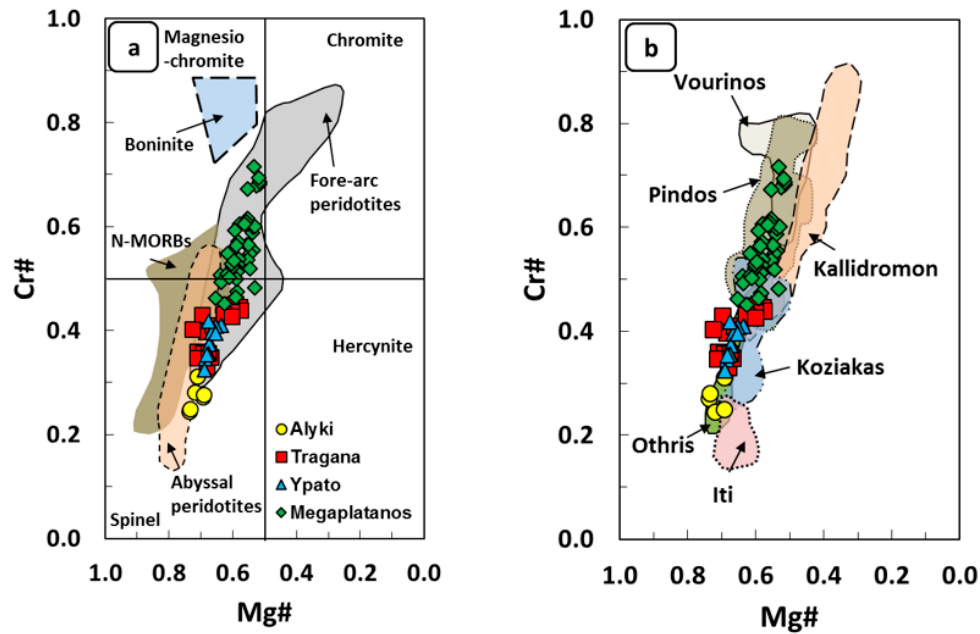
Figure 4. ( a ) Cr-spinel compositions from Lokris and Beotia peridotites, in terms of Cr# vs. Mg#. Data for spinel in modern abyssal peridotites are from [1,29]. Field for spinel in boninites is taken from [1]. Data for spinel in fore-arc peridotites are from [30,31]; ( b ) Comparison of Cr-spinel compositions from Lokris and Beotia peridotites with spinels from Othris, Pindos, Vourinos, Koziakas, Kallidromon and Iti ophiolites, on a Cr# against Mg# diagram (fields after [32–38]).